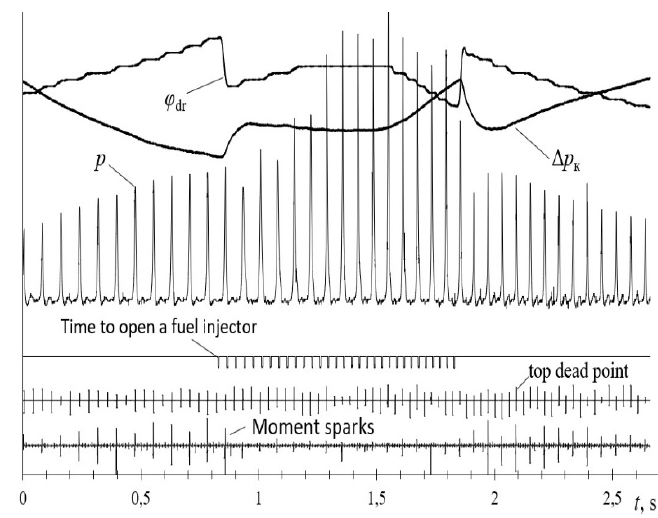
Figure 12. Fragments of oscillograms of the transition processes of the engine when a cylinder is switched on and off during acceleration and deceleration φ r : the position of the rheostat to control the stand load.